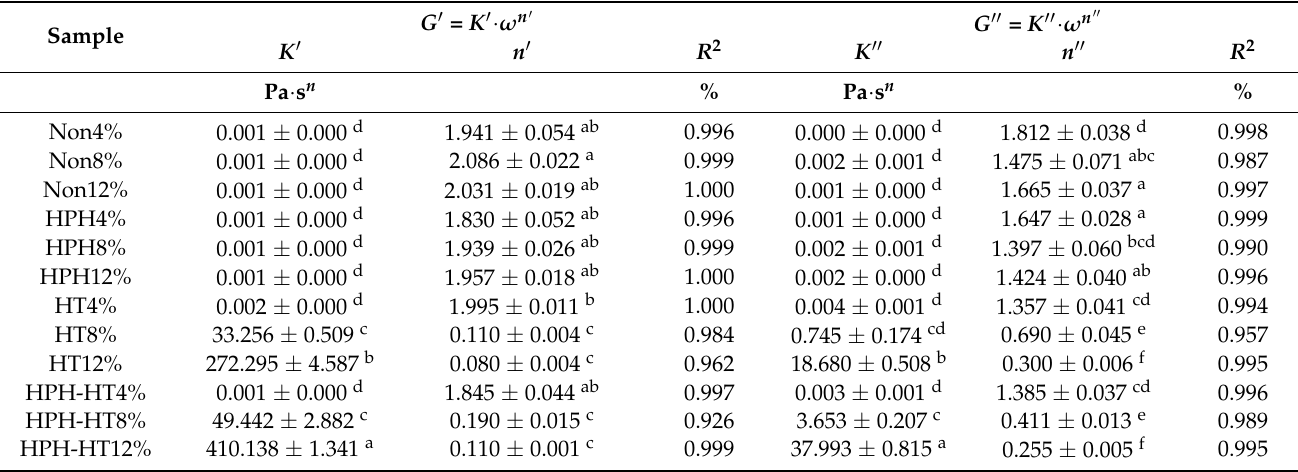
Table 3. Effects of different concentrations of defatted chickpea flour dispersions on power-law model function fitting under different